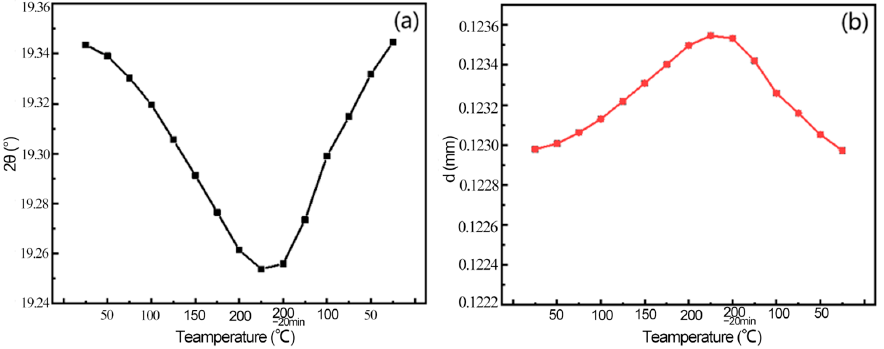
Figure 7. Variation in the process of temperature–insulation–cooling. ( a ) Diffraction angle; ( b ) crystal plane spacing.